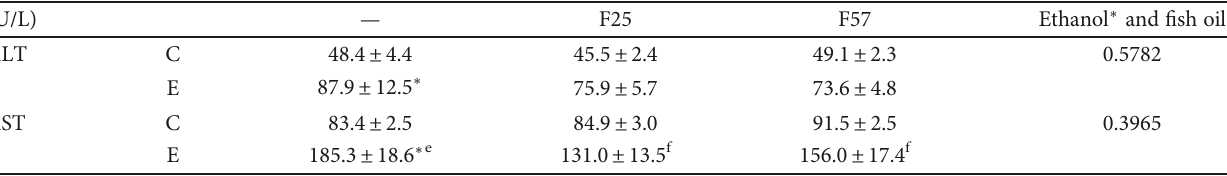
Table 2: Final plasma aspartate transaminase (AST) and alanine transaminase (ALT) activities in each group 1,2 .